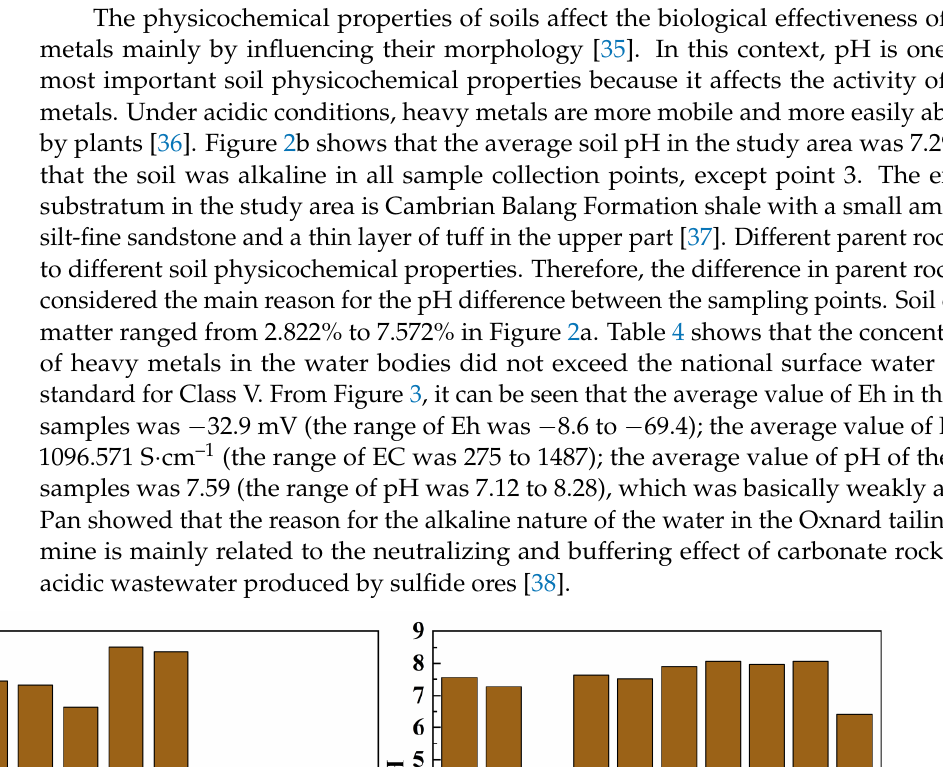
Figure 3. Physical and chemical properties of water samples: ( a ) pH; ( b ) redox potential Eh; ( c ) elec- trical conductivity EC. Table 4. Concentrations of heavy metals in water samples and respective national standard values for Class V surface water (mg/kg). Heavy Metals